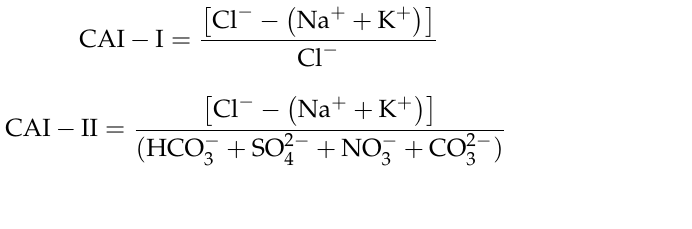
Figure 7. Plot of [(Ca 2+ + Mg 2+ ) − (HCO 3 − + SO 42 − )] versus [Na + − Cl − ]. The Schoeller indices, CAI-I (Equation (14)) and CAI-II (Equation (15)) (with all ions expressed in meq/L) were further used to indicate the type of ion exchange mechanism occurring in the aquifer [74]. Both indices would be negative if normal (forward) cation- exchange activities were prevalent, and positive if reverse cation-exchange processes were present. The CAI-I values varied from − 2.05 to 0.68, whereas CAI-II ranged from -0.10 to 0.52. Positive CAI-I and CAI-II values were exhibited by 80% of the samples, indicating reverse cation exchange, in which the Na + and K + in the groundwater are replaced by Ca 2+ and Mg 2+ from the aquifer matrix. Negative CAI-I and CAI-II values were obtained for the remaining 20% samples, indicating forward or normal cation exchange in which Ca 2+ and Mg 2+ in the groundwater are replaced by Na + and K + from the aquifer material.